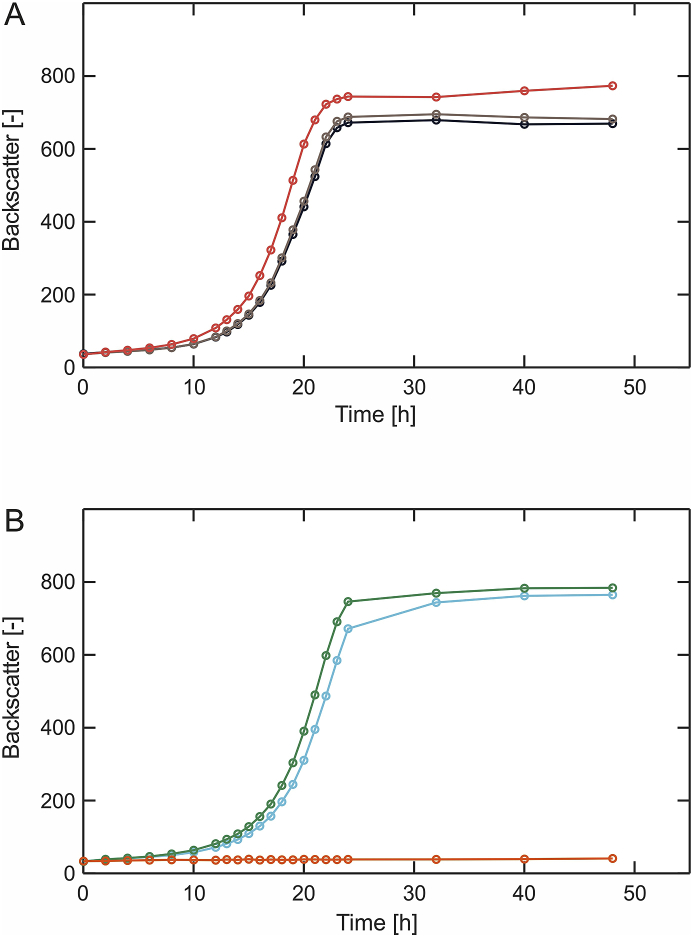
Microbioreactor cultivations of C. glutamicum strains engineered for d-xylose utilization via the Weimberg pathway. (A)C. glutamicum PO6iolT1 pEKEx3-xylXABCDCc-opt (black), C. glutamicum PO6iolT1 pEKEx3-xylXADCc-opt (brown) and C. glutamicum PO6iolT1 pEKEx3-xylXDCc-opt (red); (B)C. glutamicum PO6iolT1 pEKEx3-xylXCc-opt (cyan), C. glutamicum PO6iolT1 pEKEx3-xylDCc-opt (green) and C. glutamicum PO6iolT1 pEKEX3 (orange). All strains were cultivated in a BioLector microbioreactor system using defined CGXII medium with 40 g L−1d-xylose as sole carbon and energy source. All data represent mean values from three biological replicates. (For interpretation of the references to colour in this figure legend, the reader is referred to the Web version of this article.)